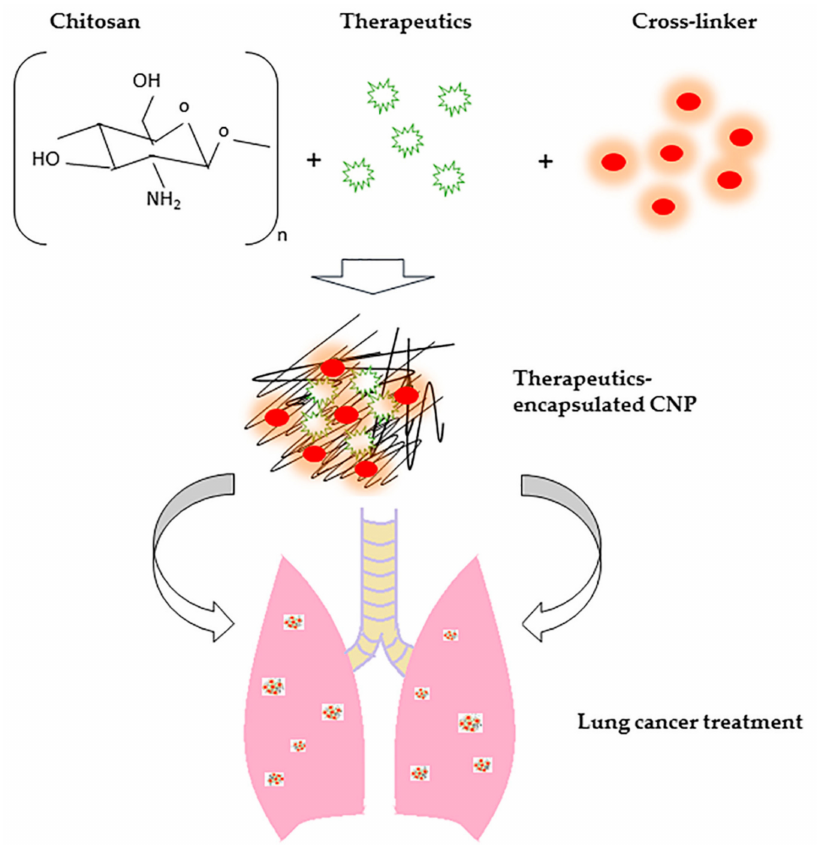
Figure 1. The illustration of the mechanism of chitosan nanoparticles (CNPs) for lung cancer treat- ment. The therapeutics were encapsulated into CNPs and delivered to the lung to achieve greater therapeutic